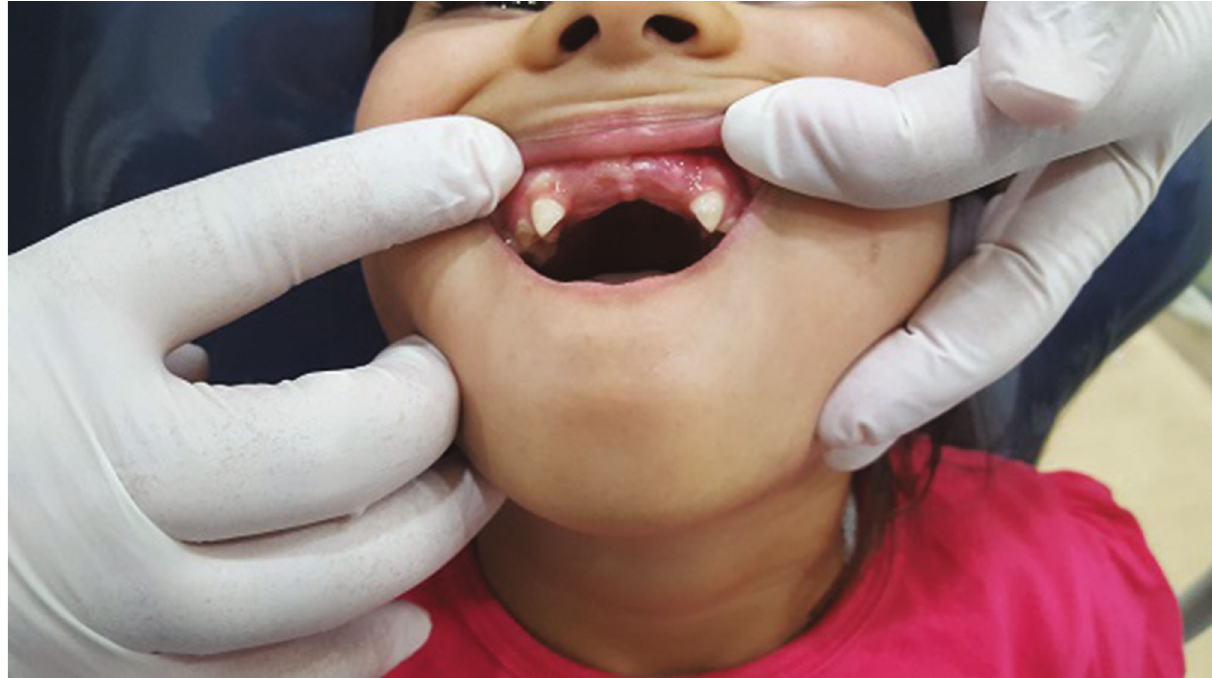
Figure 6: Clinical healing of anterior maxillary area.